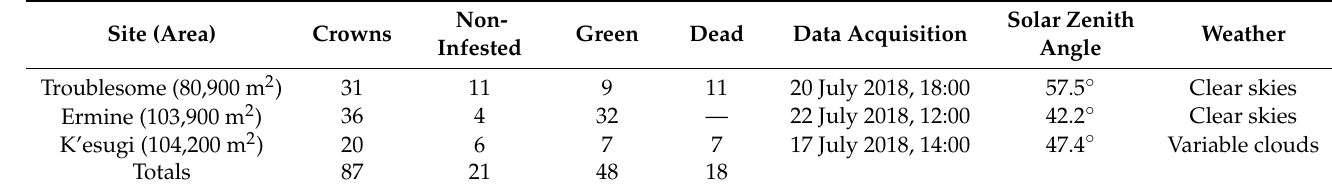
Table 1. Crown and study site